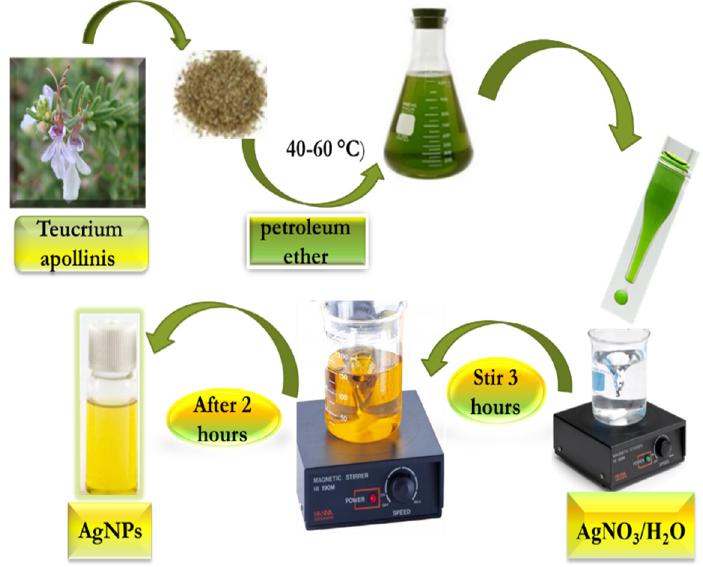
Figure 1. Process of green synthesis of AgNP using Teucrium apollinis extract as coating and reducing agents at the same time. A plant extract of (5 mL) was added stepwise to silver nitrate solution (AgNO 3 /H 2 O) with vigorous stirring. The progress of the formation of AgNPs can be observed through visual color changes or by using UV-Vis.